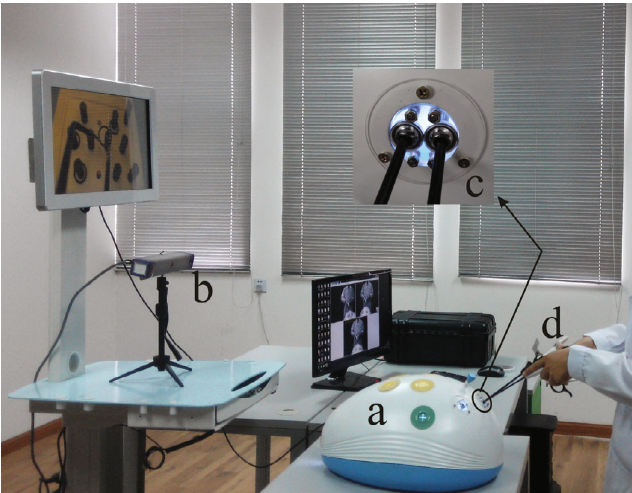
Figure 1: Apparatus and setting. (a) Laparoscopic simulator. (b) Tracking system. (c) SILS access with universal bearings. (d) An instrument with tracking marks.